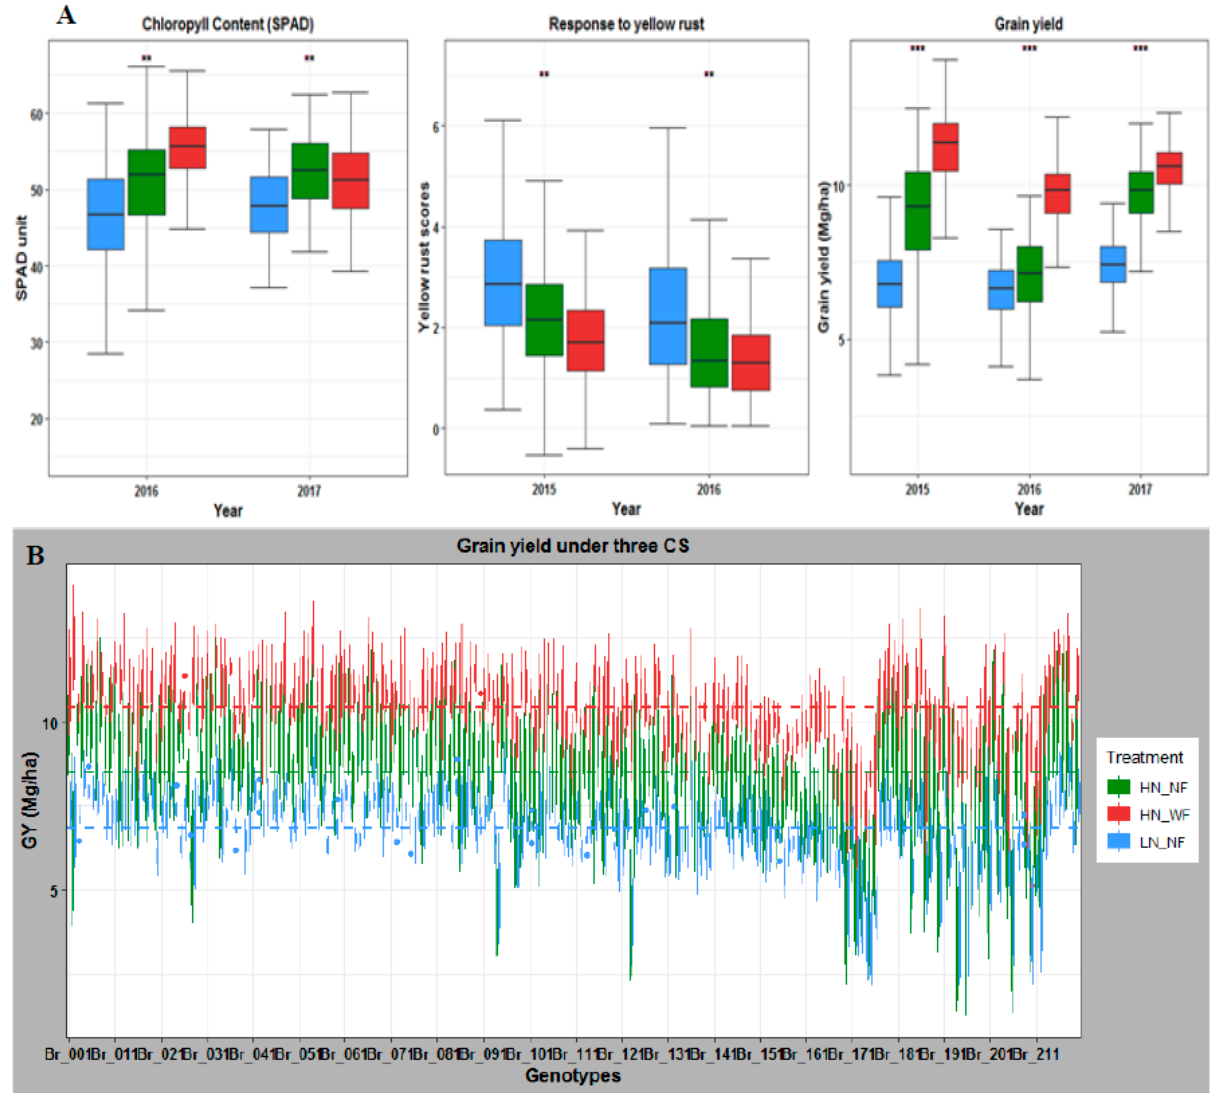
Figure 1. Differences between the three cropping systems. ( A ) Leaf chlorophyll content, plant response to yellow rust, and GY traits. ( B ) Three years averaged grain yield production (Mg·ha − 1 ) of 220 cultivars under the three cropping systems. The dashed lines indicate the GY mean under each CS: blue: LN-NF (6.850 Mg·ha − 1 ); green: HN-NF (8.507 Mg·ha − 1 ), and red: HN-WF (10.447 Mg·ha − 1 ). The symbol *, **, and *** meansignificant at p = 0.05, 0.01, and 0.001, respectivelly.